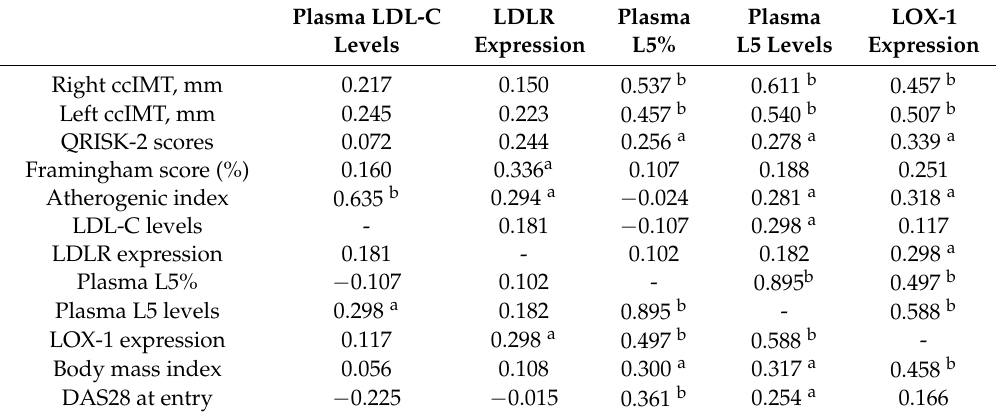
Table 2. Correlation of plasma levels of LDL-C, L5, L5%, or LOX-1 expression with the extent of